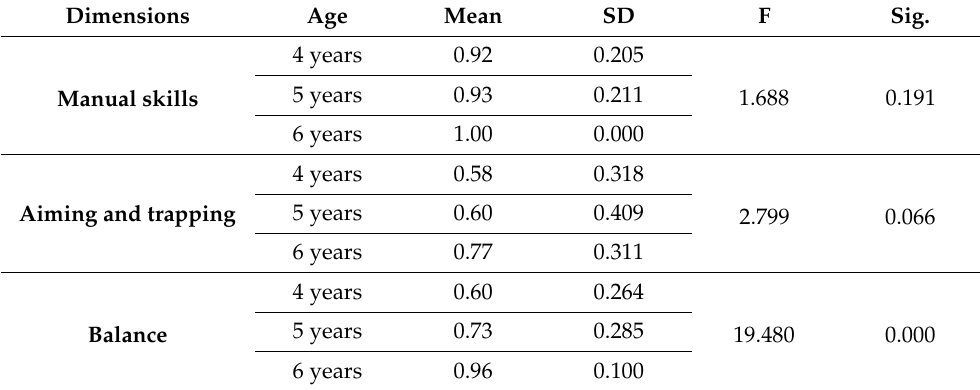
Table 2. ANOVA of the MABC-2 in relation to the age of the participants.